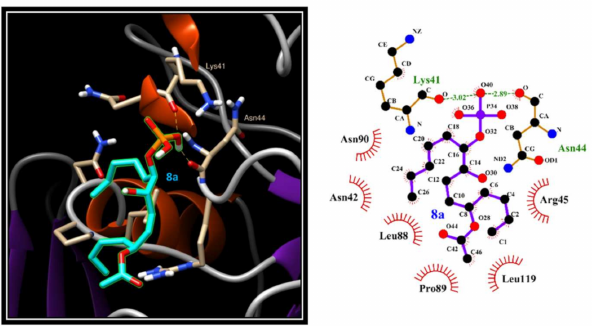
Figure 9. Interaction of compound 8a with the region lining the active site of PTP1B enzyme.